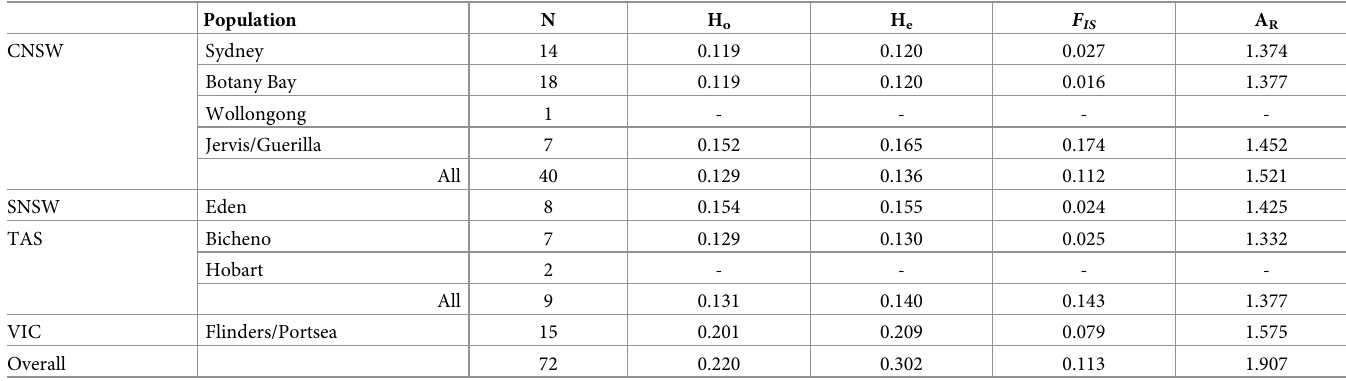
Table 2. Genetic diversity indices for P . taeniolatus